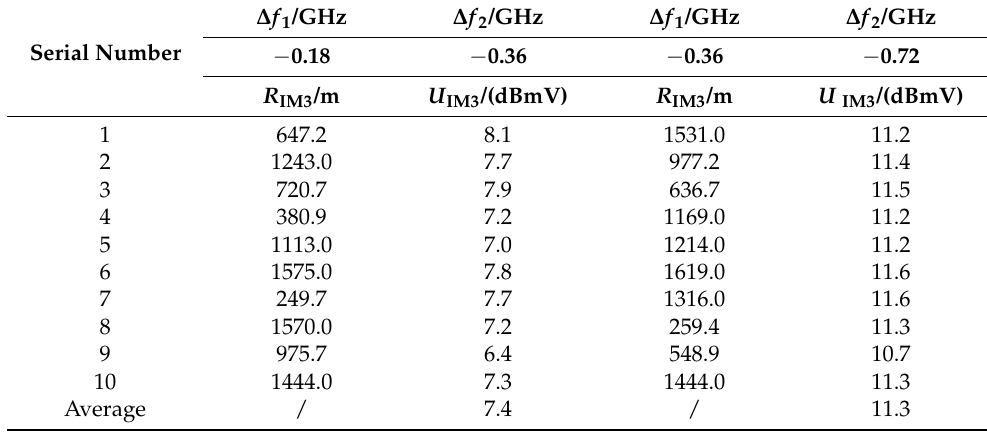
Table 2. Two groups of the IMFA-3 test results ( E 1 = 20 dBV/m, E 2 = 24.5